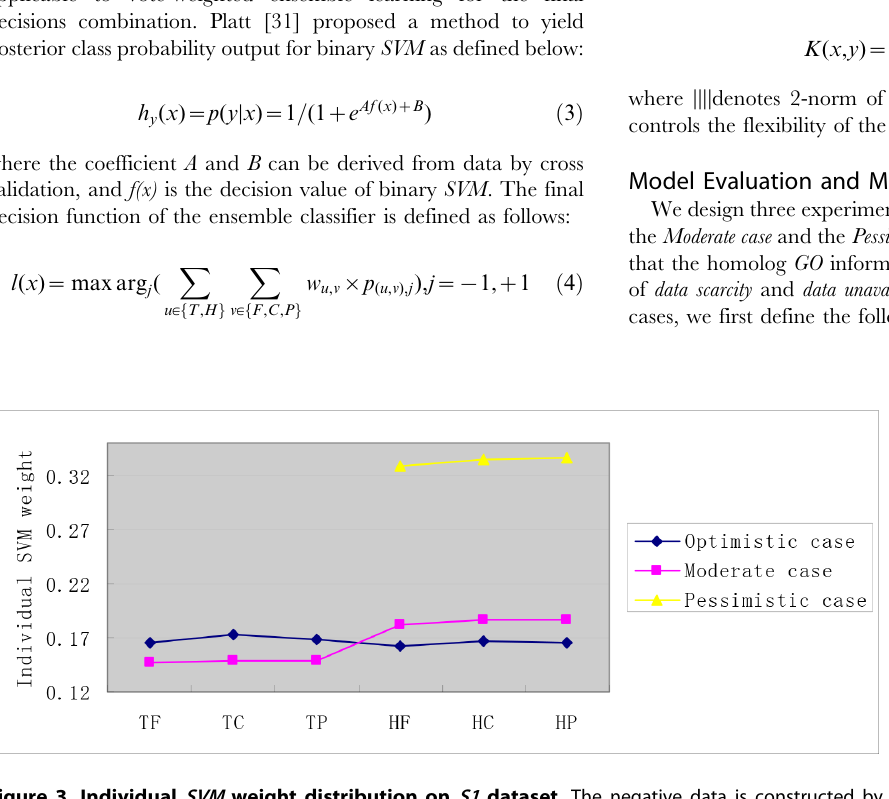
Figure 3. Individual SVM weight distribution on S1 dataset. The negative data is constructed by the negative data sampling method of exclusiveness of subcellular co-localized proteins . The horizontal axis is the combination of two sets {T, H} and {F,C, P}. T denotes the target protein, H denotes the homolog protein; F denotes molecular function , C denotes cellular component and P denotes biological process . doi:10.1371/journal.pone.0079606.g003 PLOS ONE |